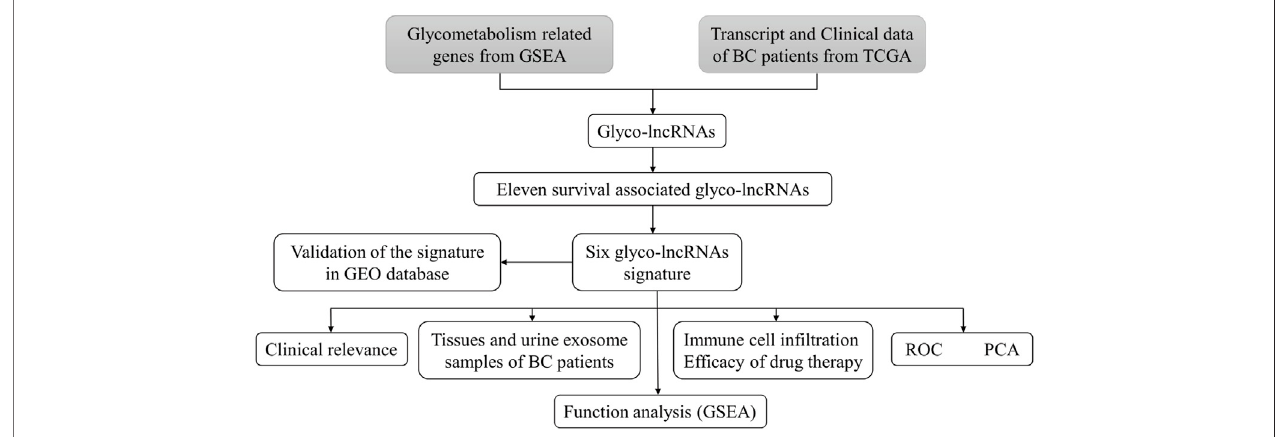
FIGURE 1 | The fl owchart of this study. TCGA, the cancer genome atlas; BC, bladder cancer; lncRNA, long non-coding RNA; glyco-lncRNAs, glycometabolism associatedlncRNAs;GEO,thegeneexpression omnibus;ROC,receiveroperatingcharacteristic;PCA,principalcomponent analysis;GSEA,geneenrichmentanalysis.